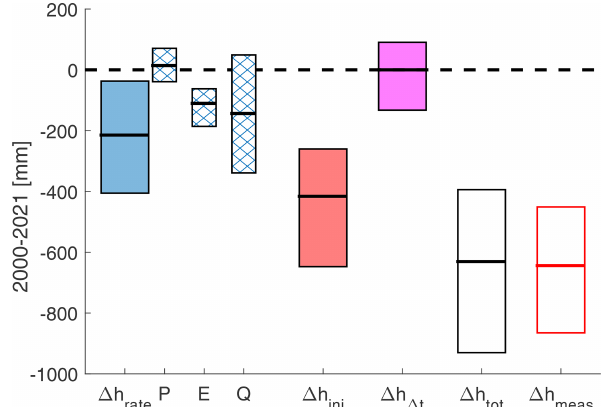
Figure 9. Impacts of hydrological changes on end-of-dry-season lake levels (95% CI). (cid:49)h rate represents the increasing rate of WSH decline during the dry season that is due to changes in precipitation ( P ), open-water evaporation ( E ), and net inflow ( Q ). (cid:49)h ini rep- resents the impact of lower initial lake levels at the beginning of the dry season, and (cid:49)h (cid:49)t represents the lake level change due to changes in the timing of the wet season. (cid:49)h tot is the sum of (cid:49)h rate , (cid:49)h ini , and (cid:49)h (cid:49)t . (cid:49)h meas is the measured difference in dry-season lake levels between 2000 and 2021 ( Q 1 in Fig. 4).